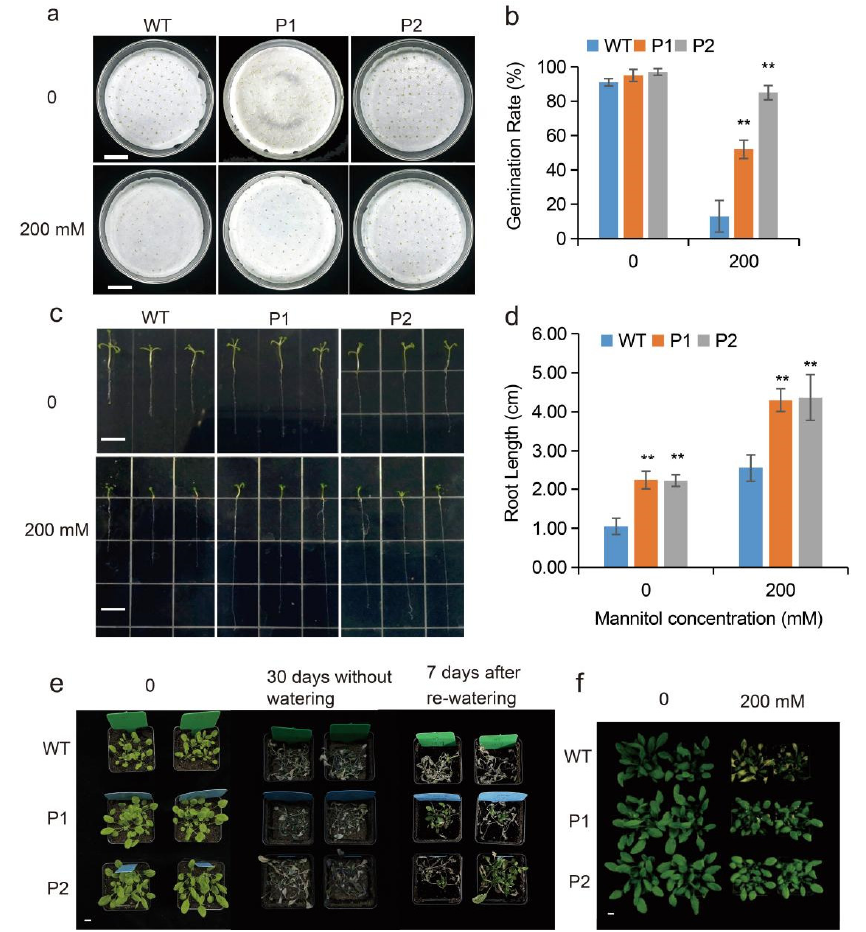
Figure 7. Effect of 200 mM mannitol treatment on germination and root growth of WT and transgenic lines (P1 and P2). ( a ) Phenotypes of WT and transgenic lines (P1 and P2) seeds. Bar = 1 cm. ( b ) The germination rate. ( c ) Phenotypes of WT and transgenic lines (P1 and P2) seedling. Bar = 1 cm. ( d ) Root length. ( e ) Phenotypes of 40-day-old WT and transgenic lines (P1 and P2) under drought stress for 30 d. Bar = 1 cm. ( f ) Phenotypes of WT and transgenic lines (P1 and P2) under 0, or 200, mM mannitol treatment at 11 d. Bar=1 cm. (** p < 0.01, one way ANOVA).